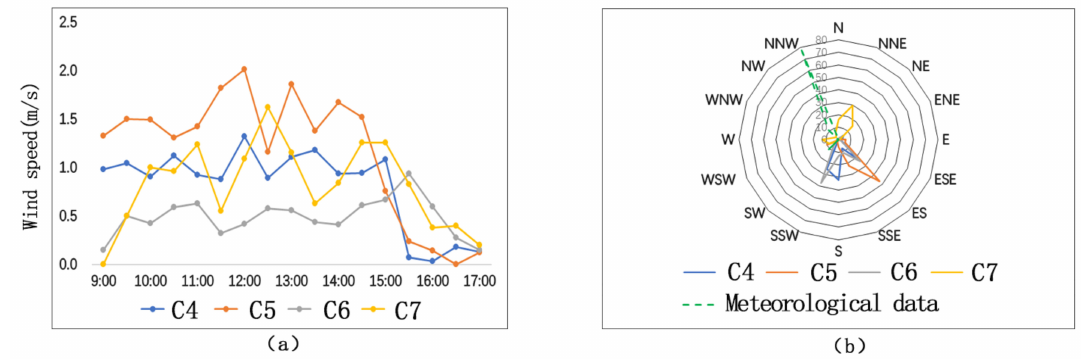
Figure 11. Comparison of wind directions and wind frequencies on semi-open-type streets: ( a ) wind speeds; ( b ) wind direction frequencies.